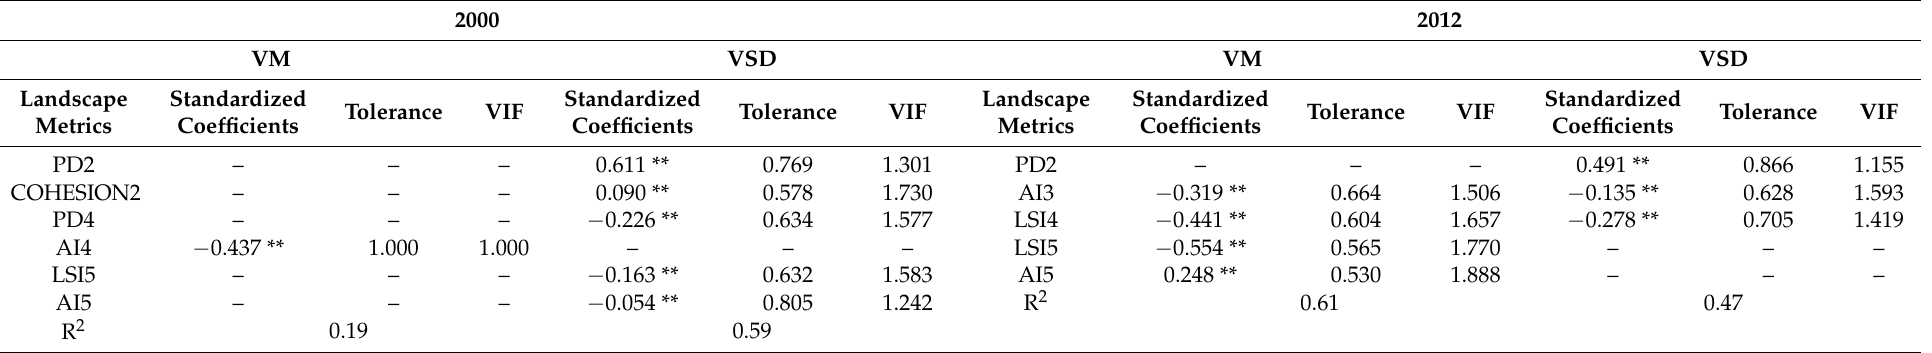
Table A4. SLR parameters of VM, VSD and class-level landscape metrics in commericial